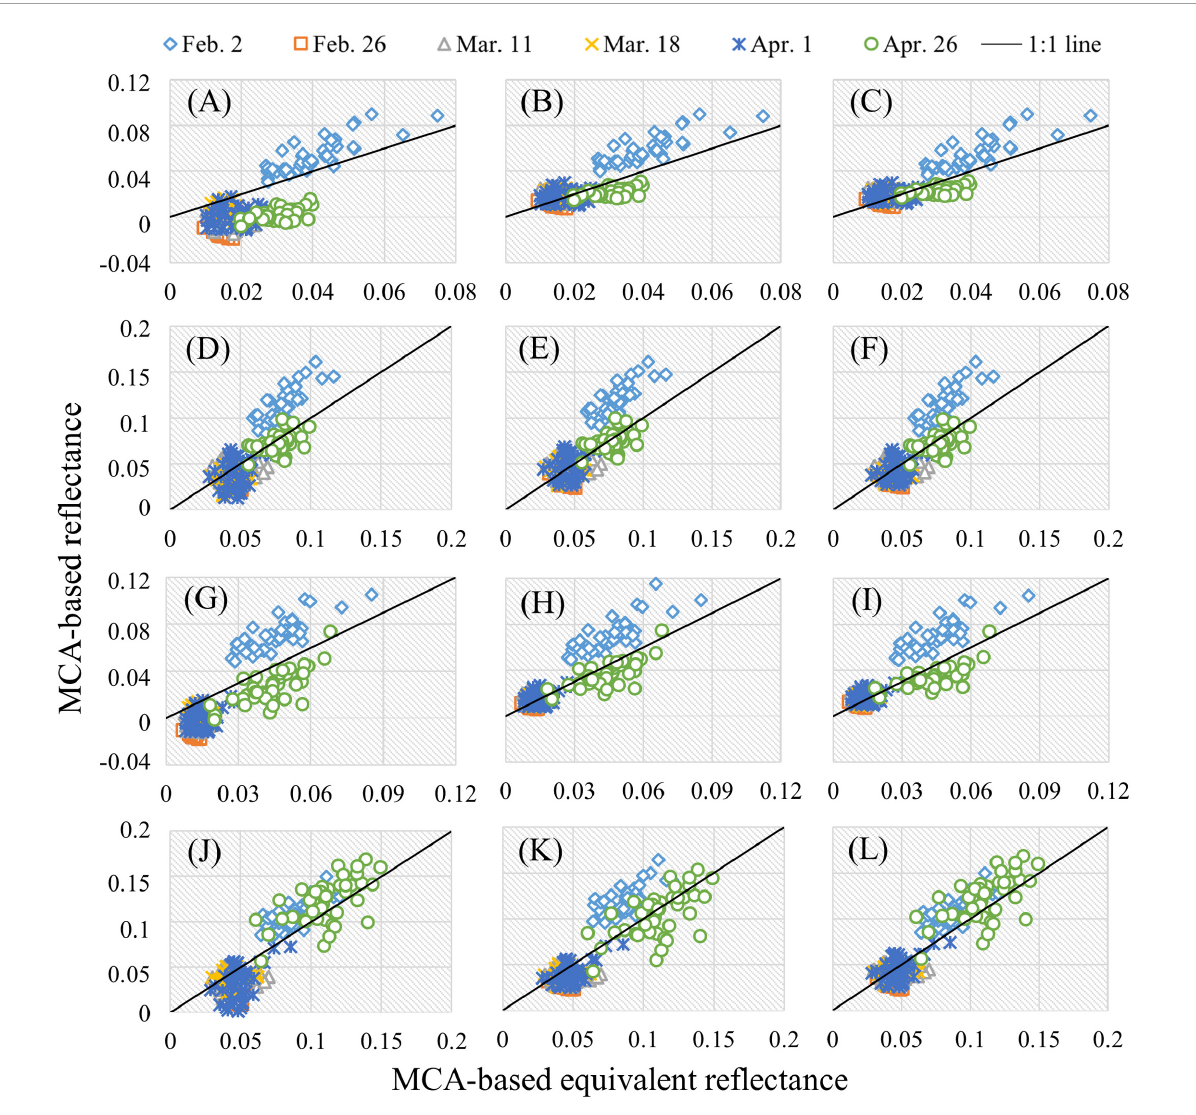
FIGURE1 Comparison of R MCA and R MCA − ASD in Test 1: (A) 490 nm and EL; (B) 490 nm and SEL; (C) 490 nm and PEL; (D) 550 nm and EL; (E) 550 nm and SEL; (F) 550 nm and PEL; (G) 670 nm and EL; (H) 670 nm and SEL; (I) 670 nm and PEL; (J) 700 nm and EL; (K) 700 nm and SEL; and (L) 700 nm and